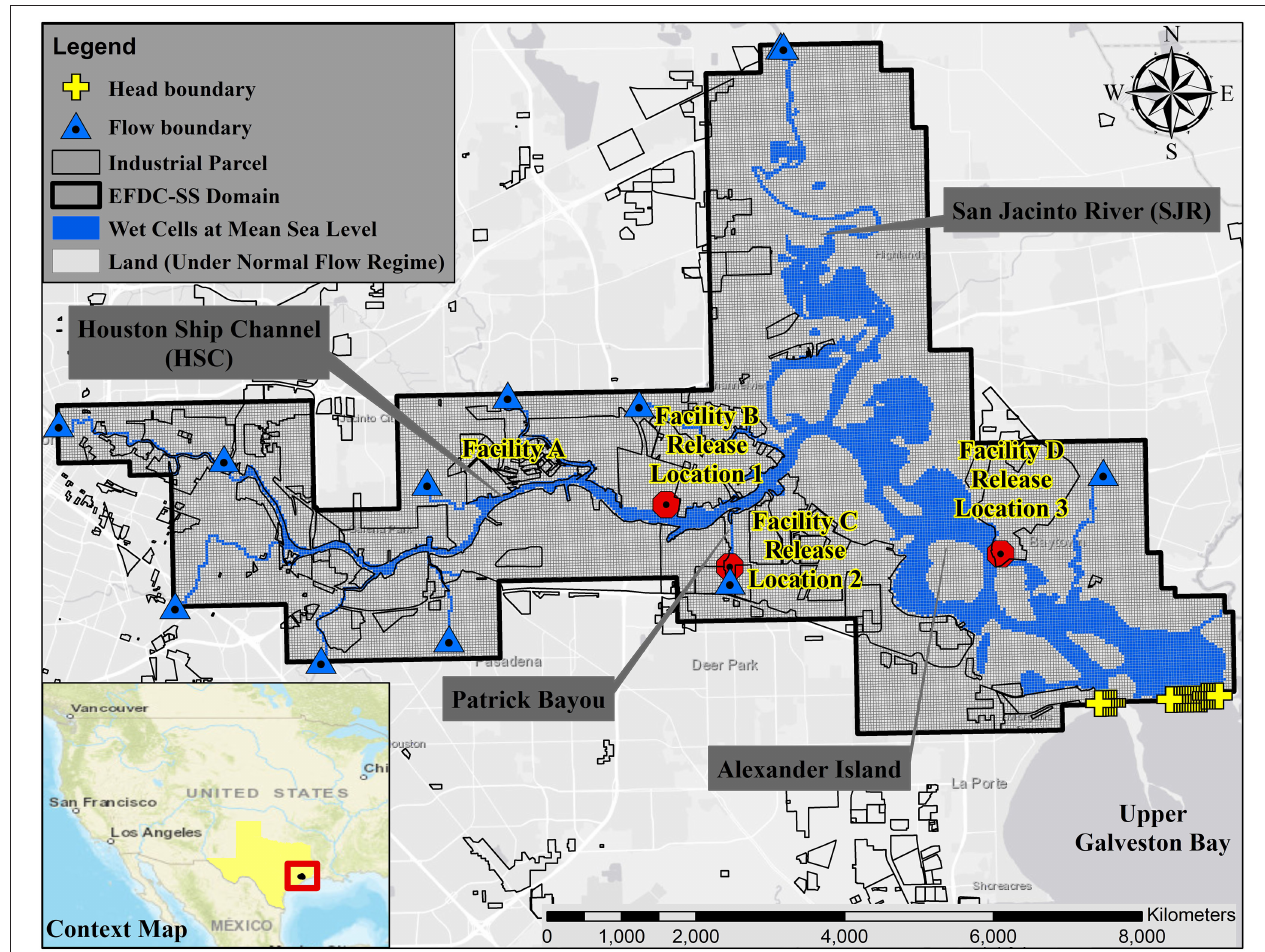
FIGURE 2 | Modeled domain with